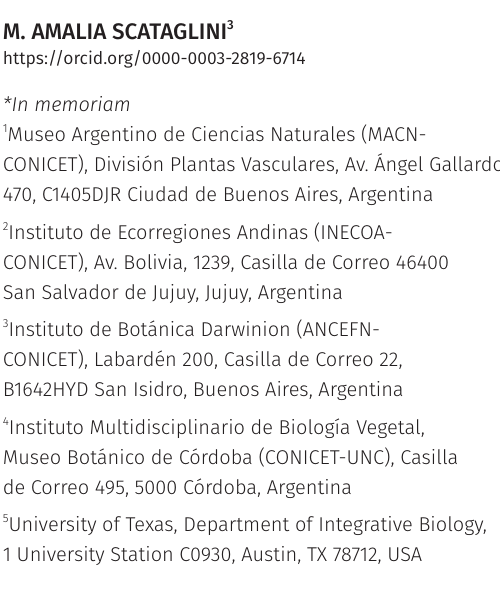
Figure S1. Parsimony strict consensus tree obtained from the separate analysis of the nuclear matrix. The two clades of Flourensia are indicated: North American species clade and the South American species clade. Numbers above branches indicate Bootstrap values (BS) and below branches Posterior probabilities (PP) obtained in the Bayesian analysis of the same matrix. Only values of BS ≥ 50% and PP ≥ 0.95 are reported. Figure S2. Maximum Credibility Tree obtained from the Bayesian analysis of the nuclear matrix. The tree is visualized with FigTree and Posterior probabilities are shown. The two clades of Flourensia and the Enceliinae subtribe are